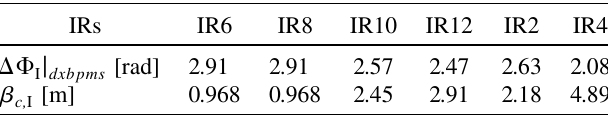
TABLE II. (cid:1) at the IR centers calculated from the phase I advances between DX BPMs. IRs